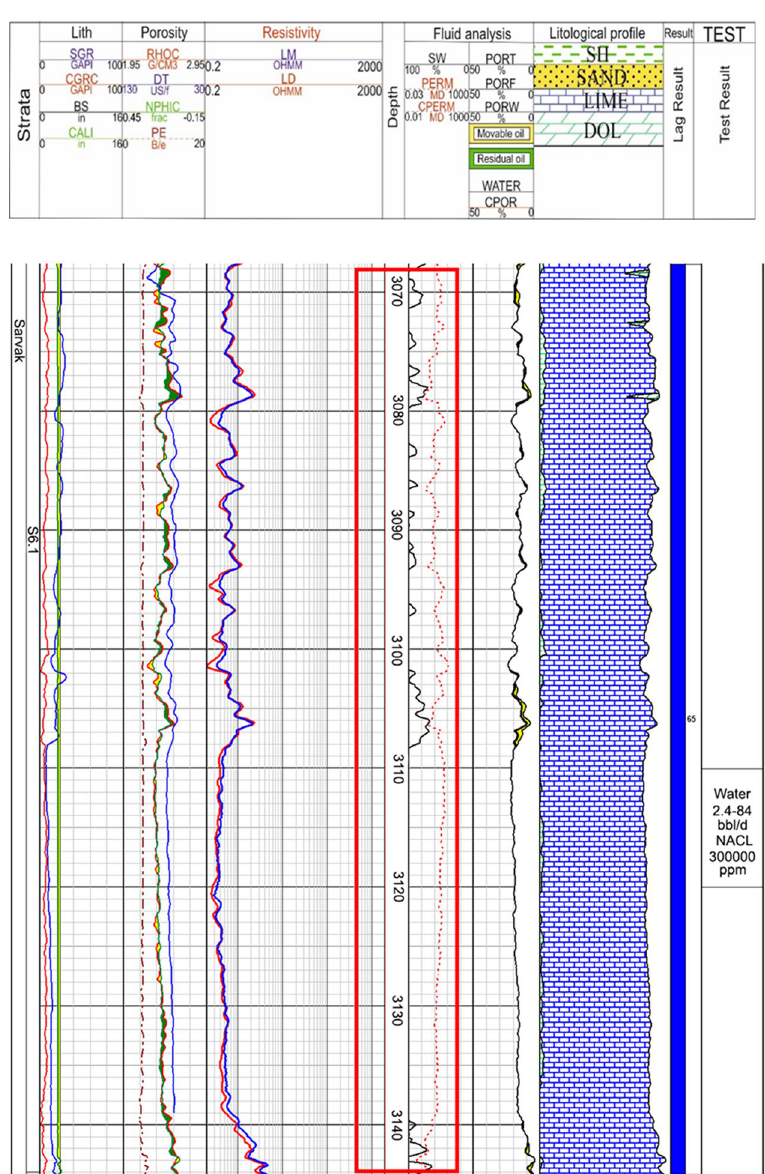
Fig. 18 Composite well log saline water from depth interval 3070–3140